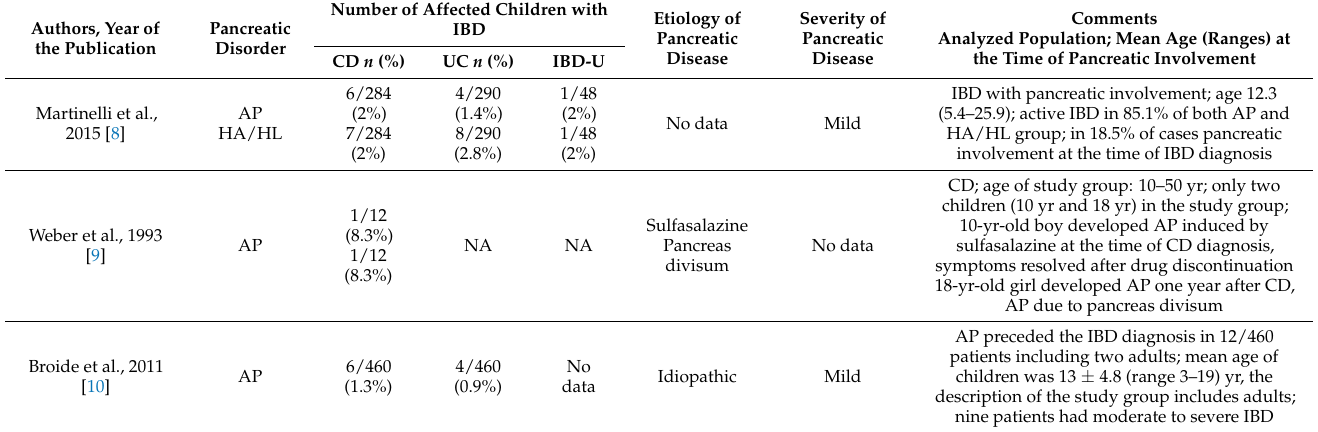
Table 1. Pancreatic disorders reported in children with IBD based on research studies.